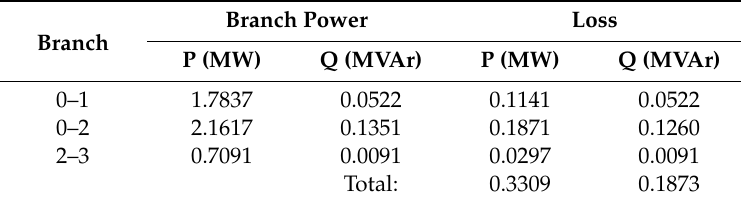
Table 5. Optimized branch data.